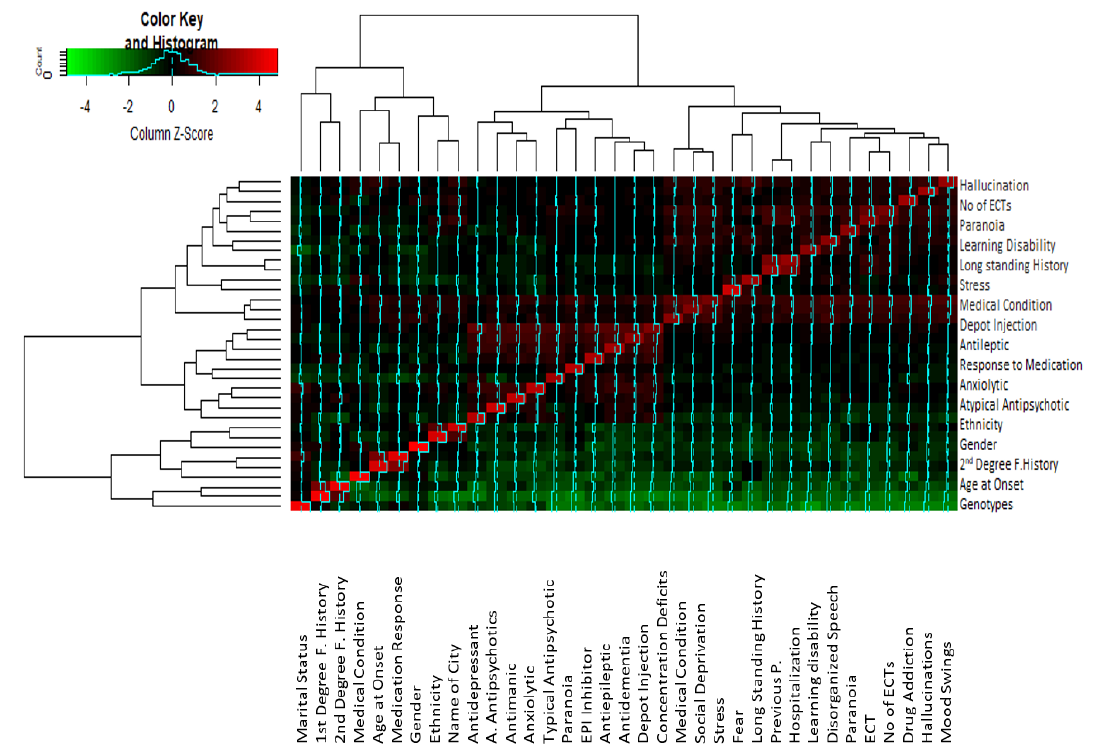
Figure 4. Cluster heatmap showing the correlation between different studied variables. The clusters analysis links the different values on the base of the z-score differences, and the correlated variables are clustered together with the least difference between them. The closely related variables with maximum z-scores are shown in red, while those with minimum z-scores are represented by green. Note: F. History refers to Family history. Antipsychotics refers toatypical antipsychotics. Table 2. Association between medication response and other variables in the generalized linear regression model.